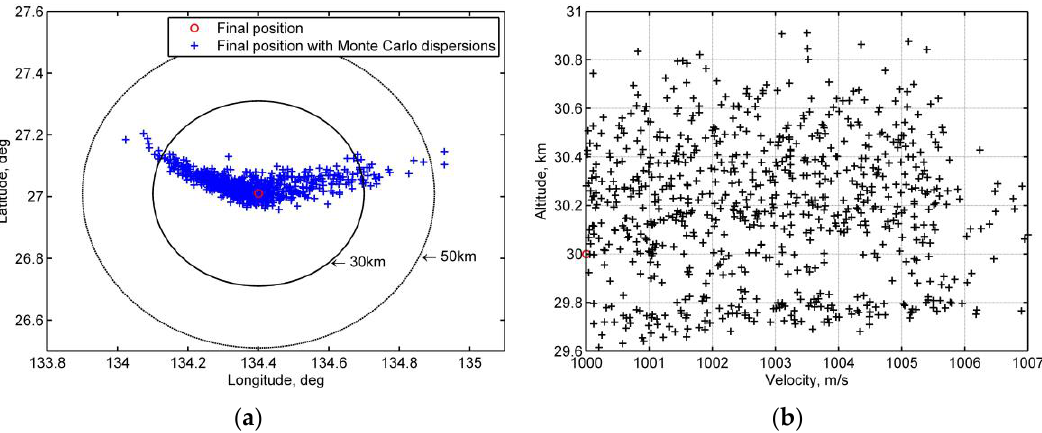
Figure 12. Final position deviation between nominal re-entry and re-entry with Monte Carlo dispersion (1000 trials): ( a ) final position deviations ( b ) velocity and altitude deviations.